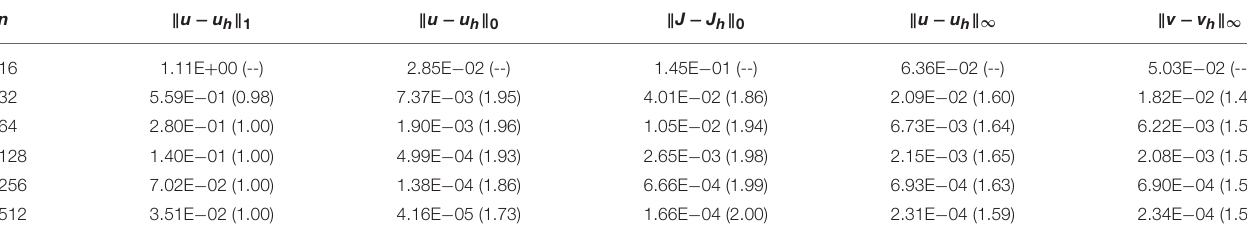
TABLE 3 | Convergence of the mortar finite element method for the manufactured test problem, with convergence rates in parentheses. n